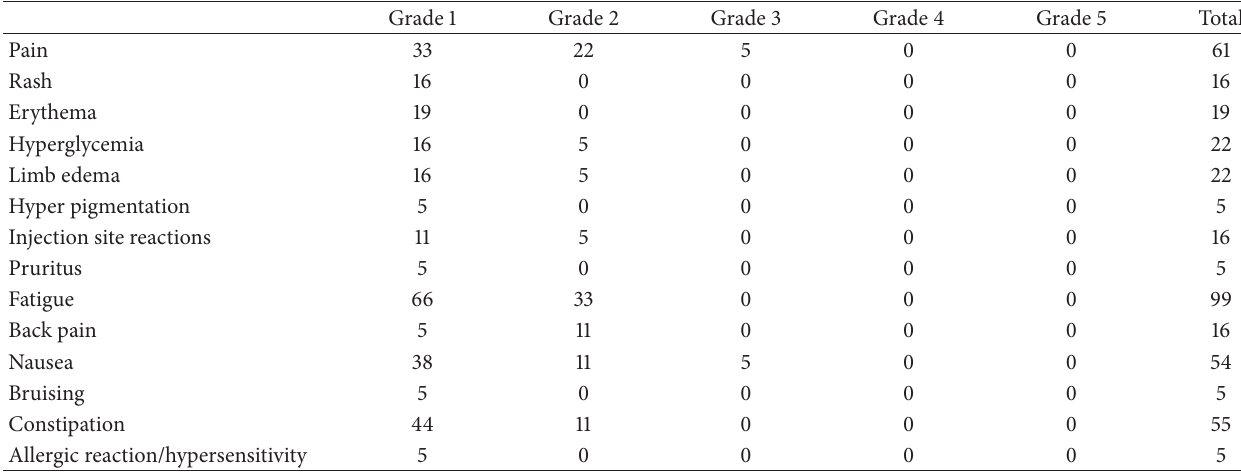
Table 2: Common adverse events of Phase I trial combining neoadjuvant radiation and dendritic cell injections subdivided by grades 1–5 and total number of events during the course of the